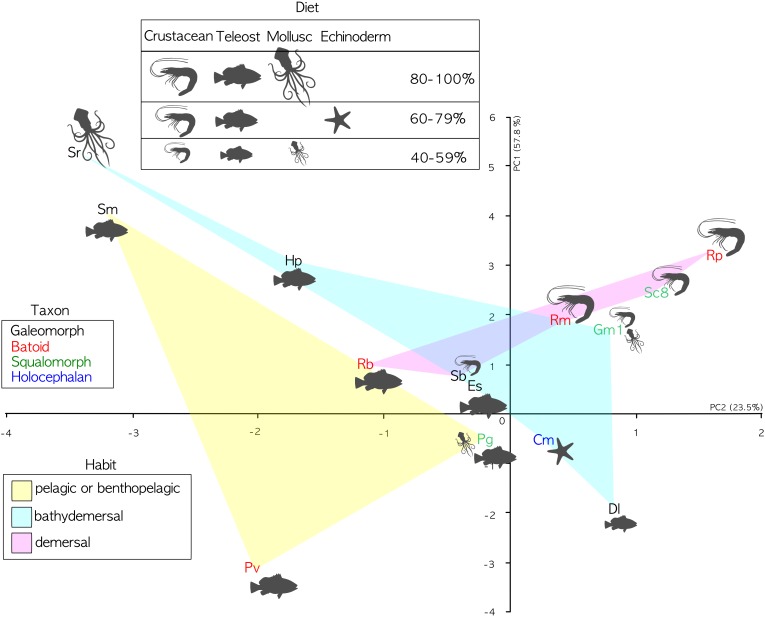
PCA analyses. PC1 explains 57.8 of variance; PC2 explains 23.5 of variance. Specimen abbreviations are written in different color according to sub-class or super-order: blue denotes the Holocephali, red Batoidea, green Galeomorphi, and black Squalomorphi. The light colored areas represent different habitats: yellow pelagic and benthopelagic; pink demersal; and light cyan bathy-demersal. Feeding preferences (cf. Table 3) are plotted only when a given prey item represents a substantial part of the diet (>40%). The larger the drawing of the prey item, the higher the percentage.